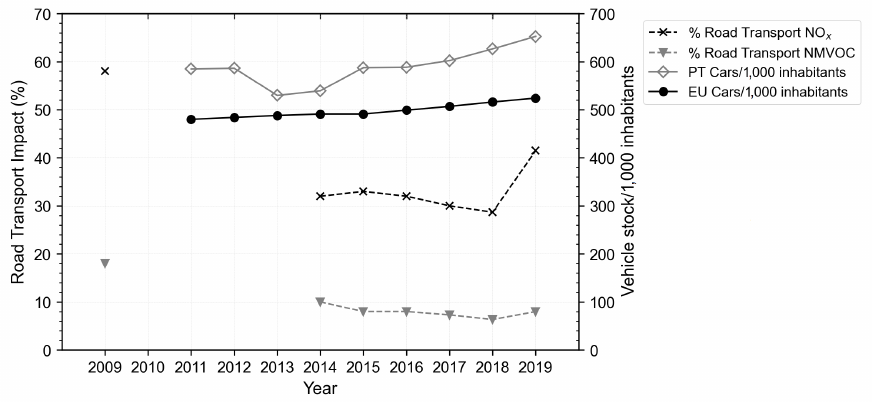
Figure 1. Motorization index and road transport contribution to NO x and NMVOC (excel data in supplementary info). Missing data from EUROSTAT is not represented. Data is taken from the European Environment Agency